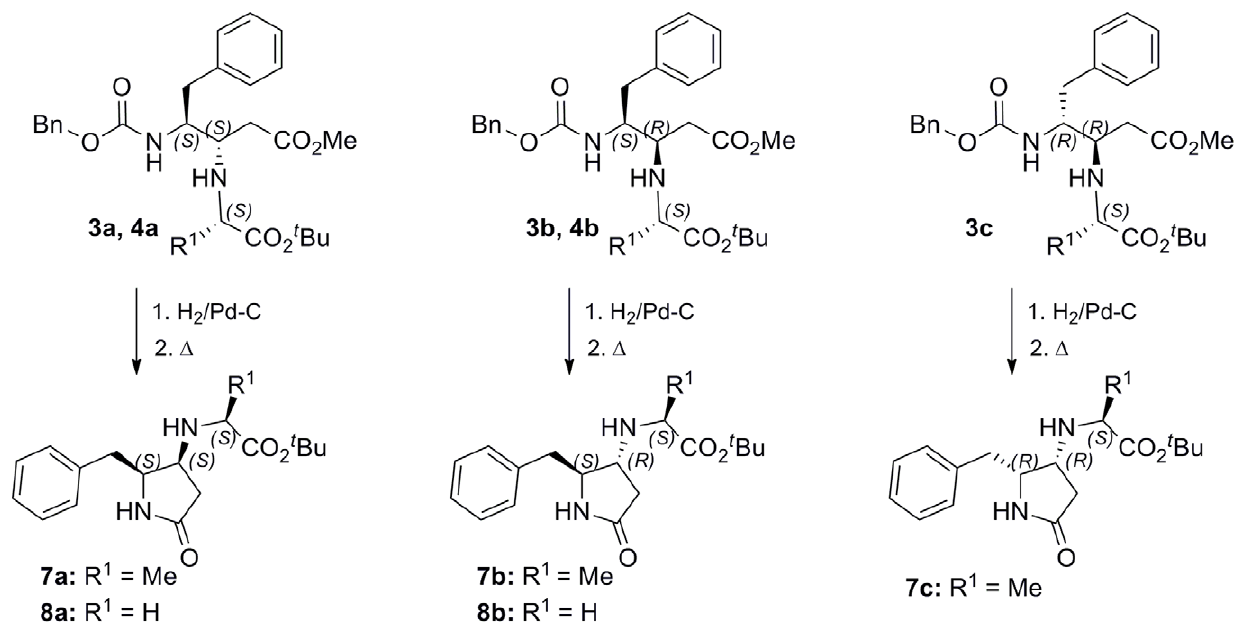
Figure 4. Synthetic procedure for 4,5-disubstituted 2-pyrrodinones from b , c –diamino ester derivatives.